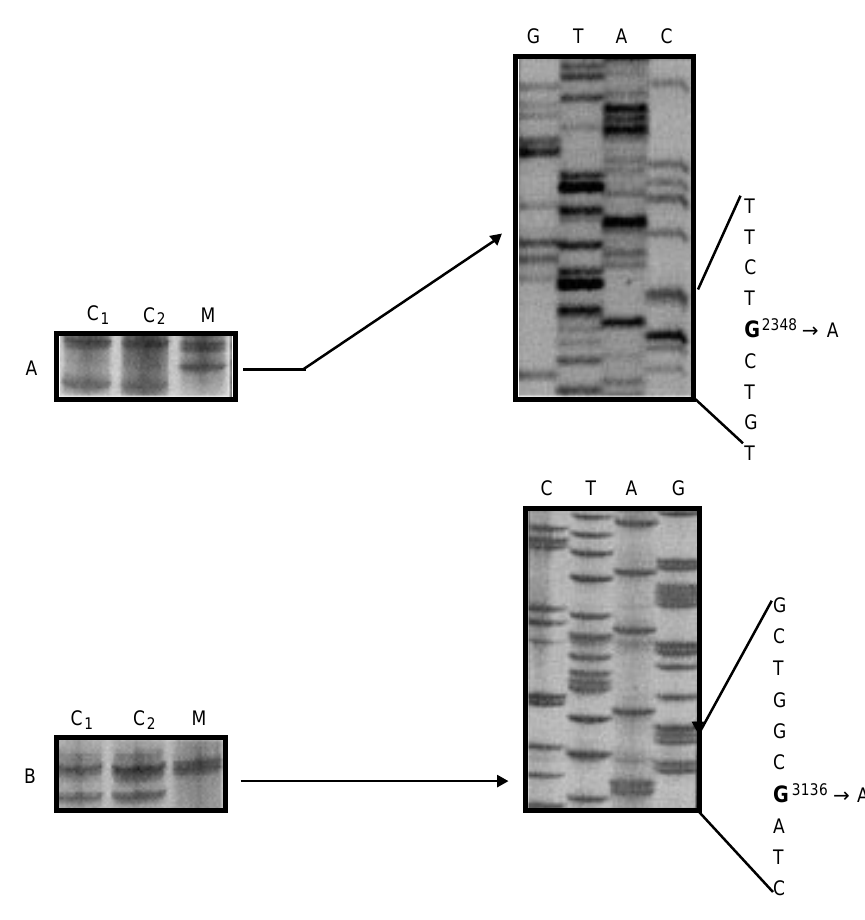
Figure 1 - Non-isotopic SSCP (left) and sequencing analysis (right) of patients 1 (A) and 2 (B). The sequence numbering adopted was that established by Lubahn et al. (5). C, Control; M,